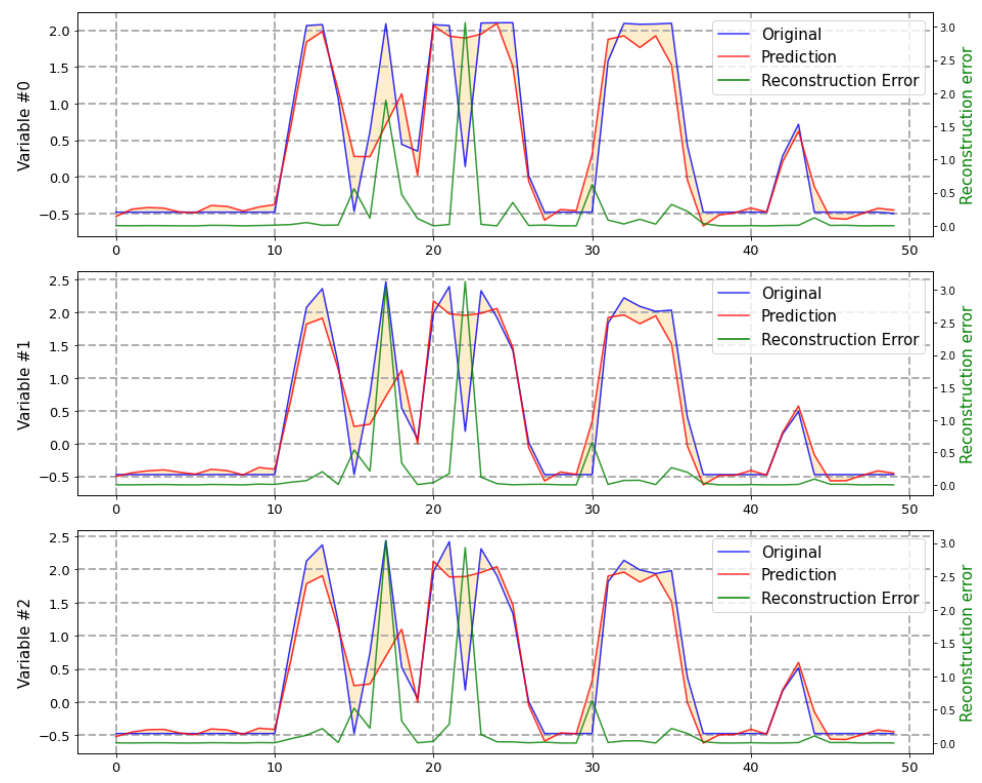
Figure 8. LSTM autoencoder output (red) with the contribution of each attribute (green) and the original value (blue) for the diesel generator.